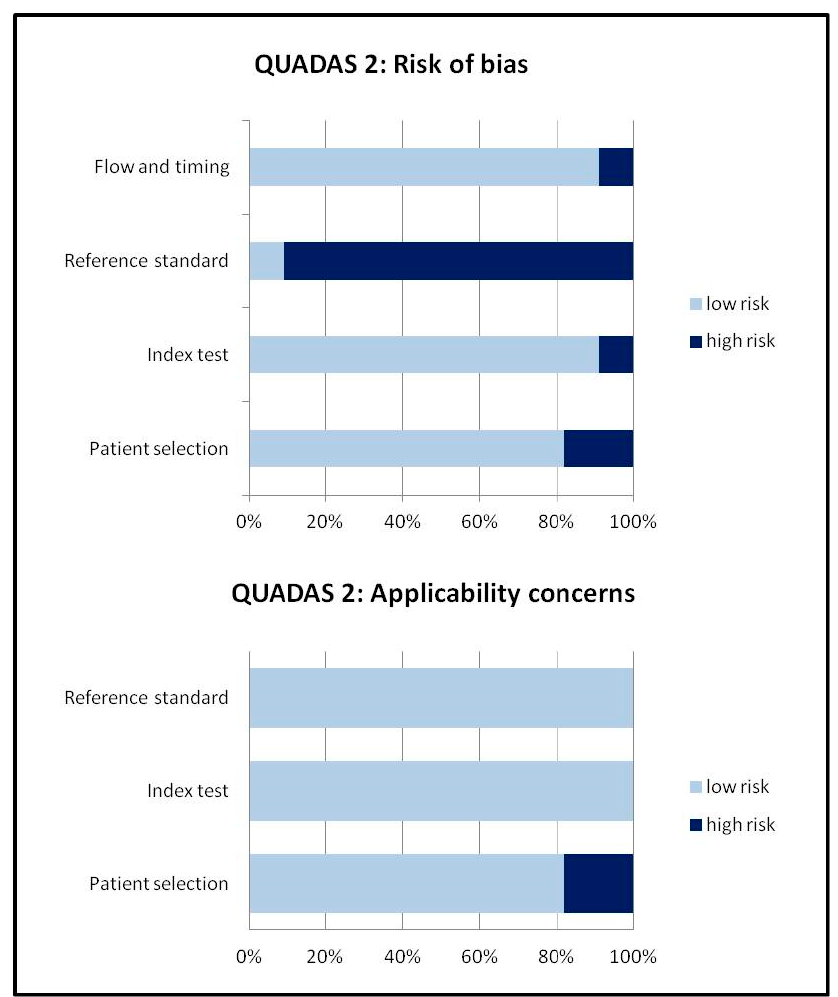
Figure 3. Quality assessment of the included studies according to QUADAS-2 tool.